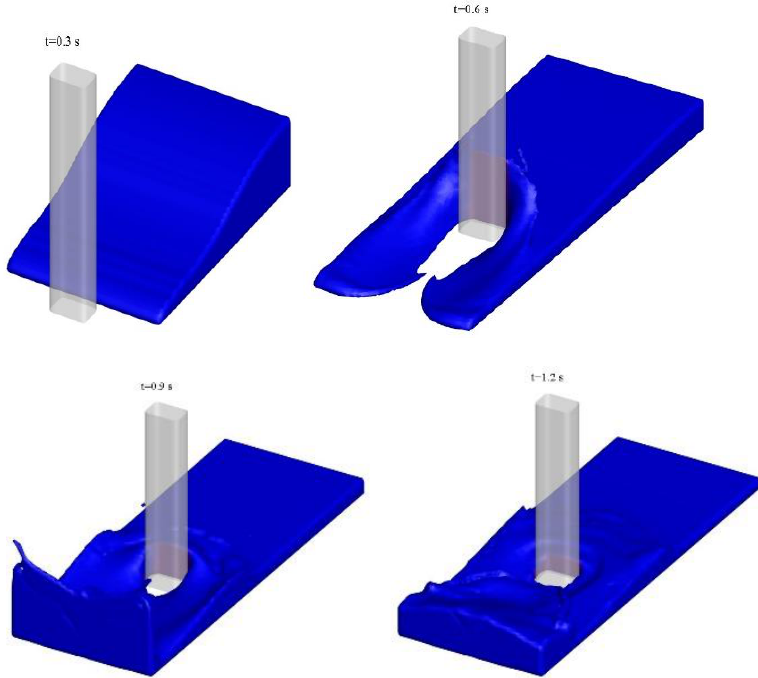
Figure 8. Simulation of the 3D dam-break flows over a vertical rectangular obstacle ( α = 1.5 ).